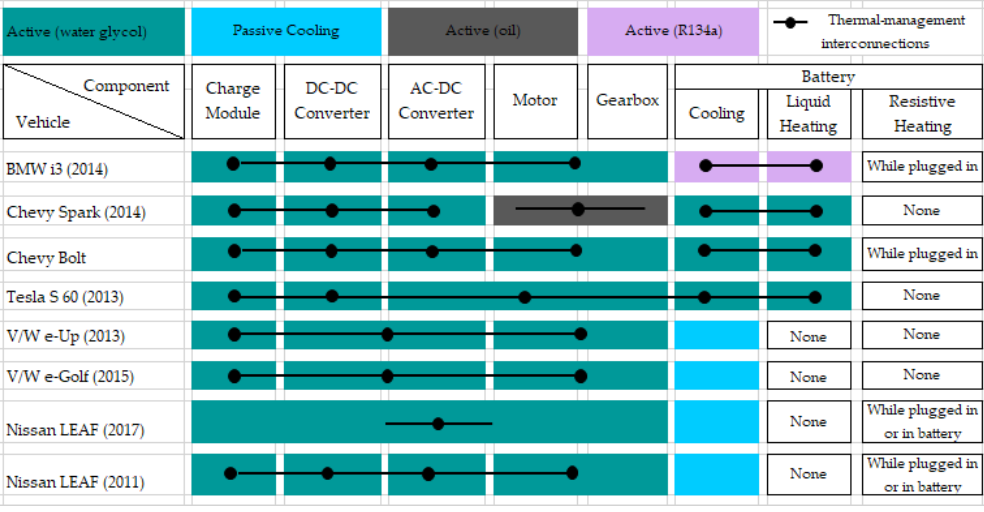
Figure 11. Thermal management systems of selected vehicles (adapted from [52]) (Note: Tesla has combined heating and cooling of the battery with the power train; Chevy Spark and Bolt have standalone battery heating and cooling; BMW has combined heating and cooling of the battery with the air-conditioning).